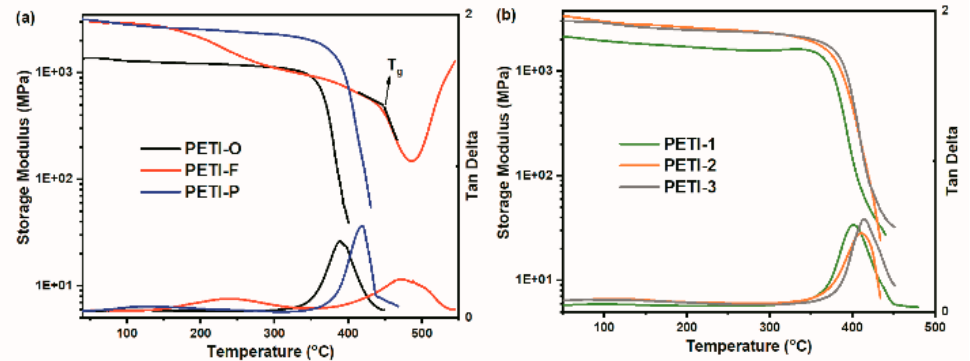
Figure 16. Thermogravimetric analysis (TGA) curves of cured resins in N2 atmosphere; ( a ) curves of cured PETI-O, PETI-F and PETI-P; ( b ) curves of cured PETI-1, PETI-2 and PETI-3